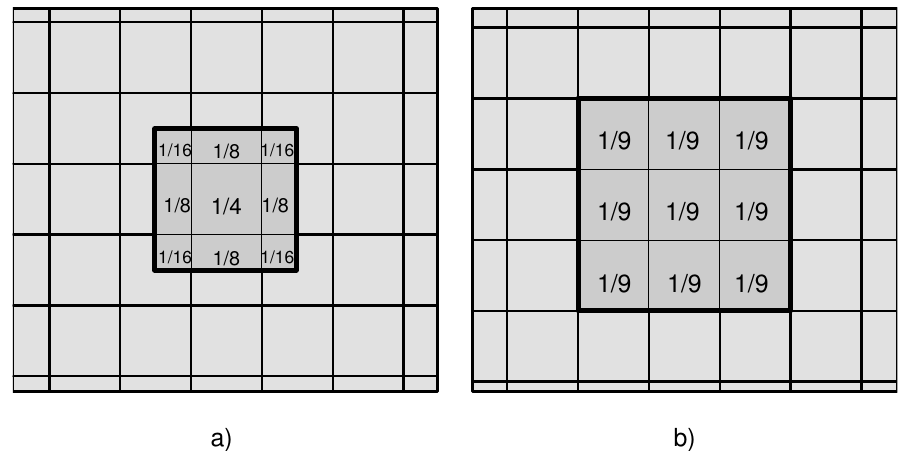
Figure 3. Area proportion occupied by neighbouring pixels for uniform distribution shifts from the center of the pixel, with 1 pixel maximum shift in ( a ) and 1.5 pixel maximum shift in ( b